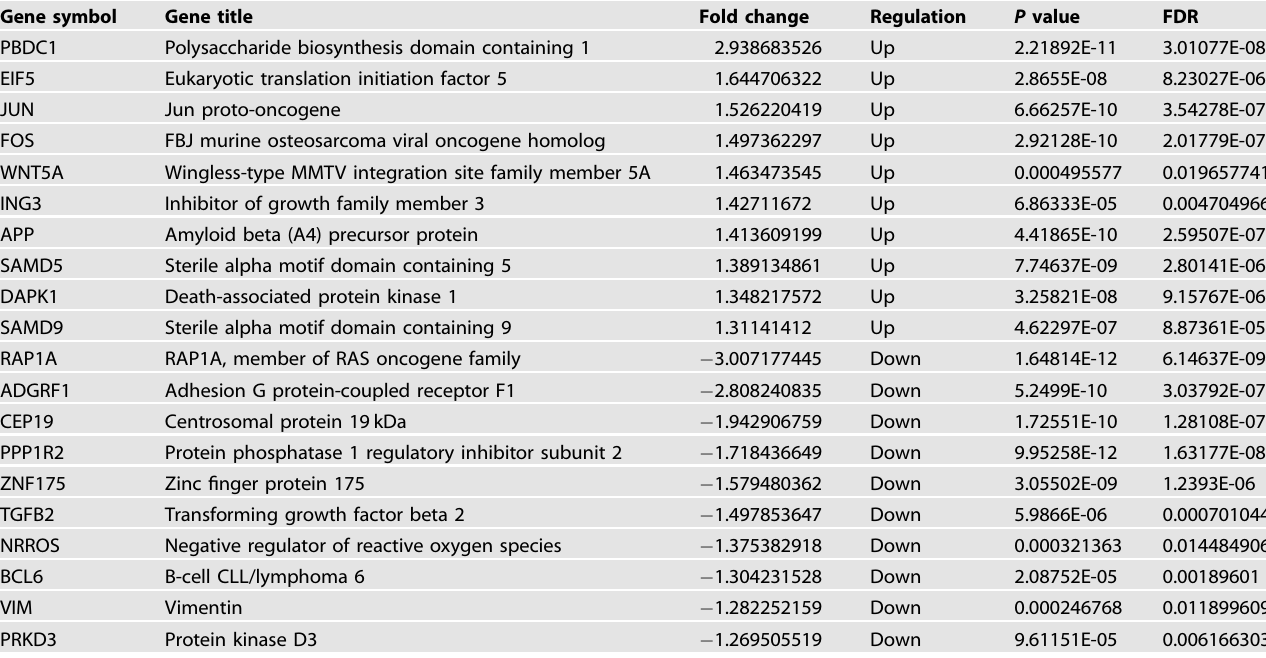
Table 1. A part of differentially expressed genes is